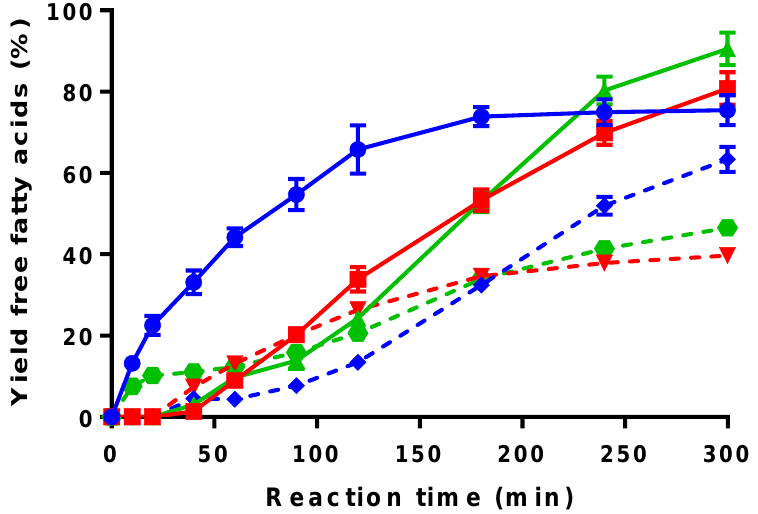
Figure 3. Time dependent monitoring of safflower oil hydrolysis at pH 8 with 5% ( w / v substrate) of = Amano lipase from P. fluorescens , (cid:78) = lipase CCL, (cid:4) = lipase AY, (cid:7) = lipase M, (cid:72) = lipase F-AP 15 and = lipase PS.